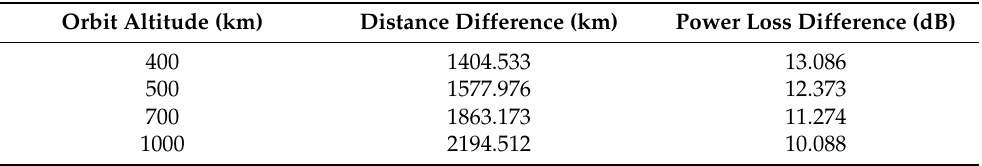
Table 1. The change in slant range and transmitted power loss for a satellite between 5 ◦ and 90 ◦ elevations, calculated for different orbits. The values do not consider the atmospheric loss and attenuation, which is also proportional to the slant